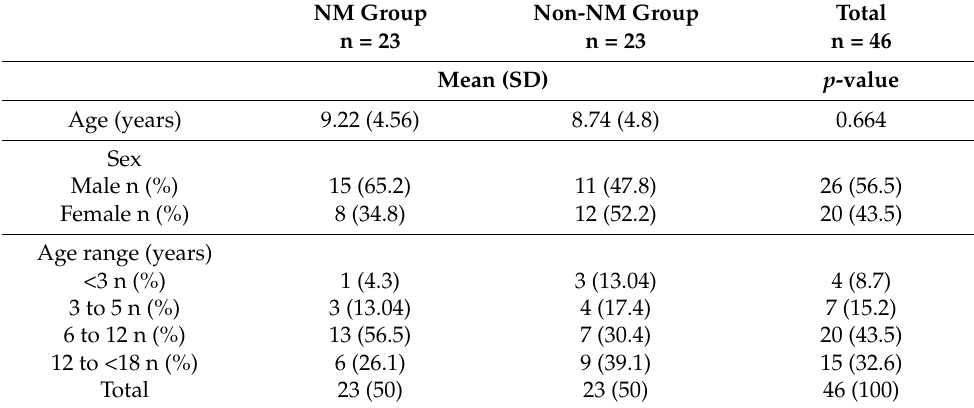
Table 1. Distribution according to the age and sex of pediatric patients with